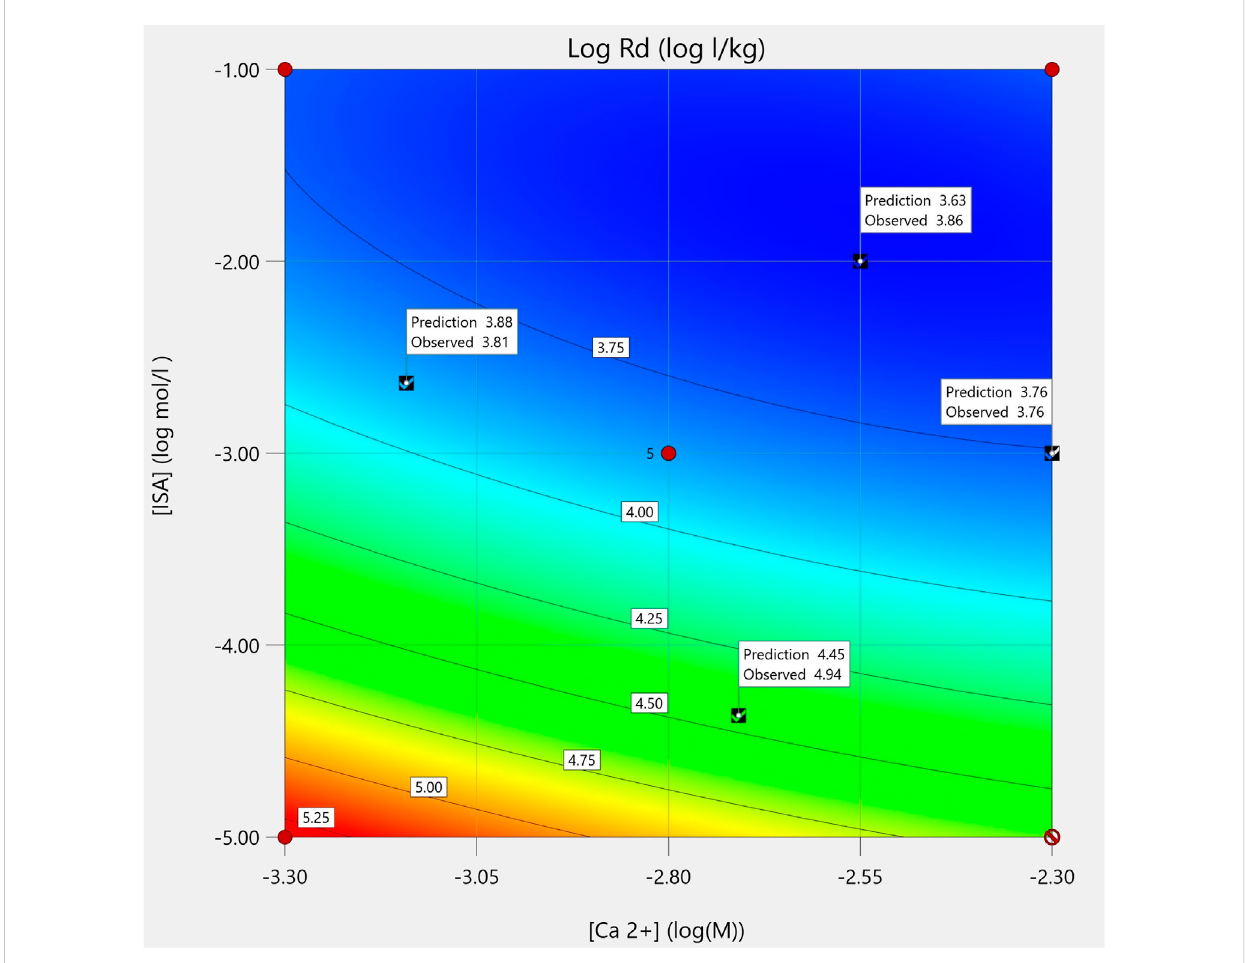
FIGURE 1 Contour plot of the model as a function of [Ca 2+ ] and [ISA] (log M), with the test points indicated with check marks and their predicted and observed